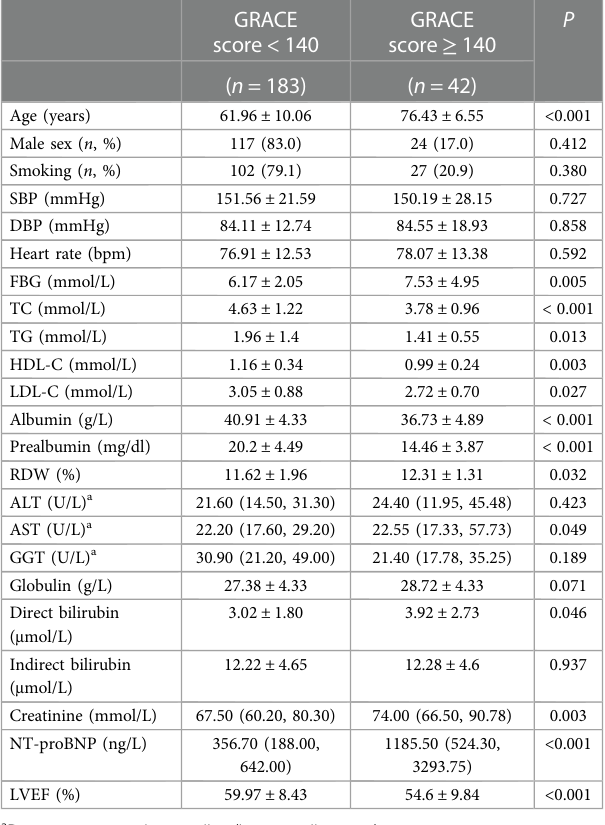
aminotransferase; GGT, γ - Glutamyl aminotransferase; NT-proBNP, N-terminal pro-brain natriuretic peptide; LVEF, Left ventricular ejection